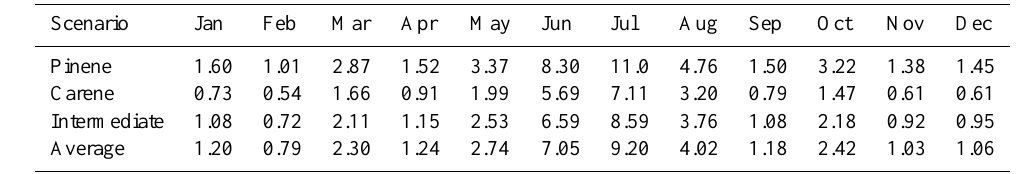
Table 2. Modelled (MEGAN 2.04) monthly mean monoterpene concentrations at 14m for the year 2007 for four different scenarios assuming that the pine trees are of either (i) pinene, (ii) carene, (iii) intermediate chemotype or (iv) average of all three types. For the scenarios, see Table 1. (Numbers in 10 9 moleculescm − 3 ).